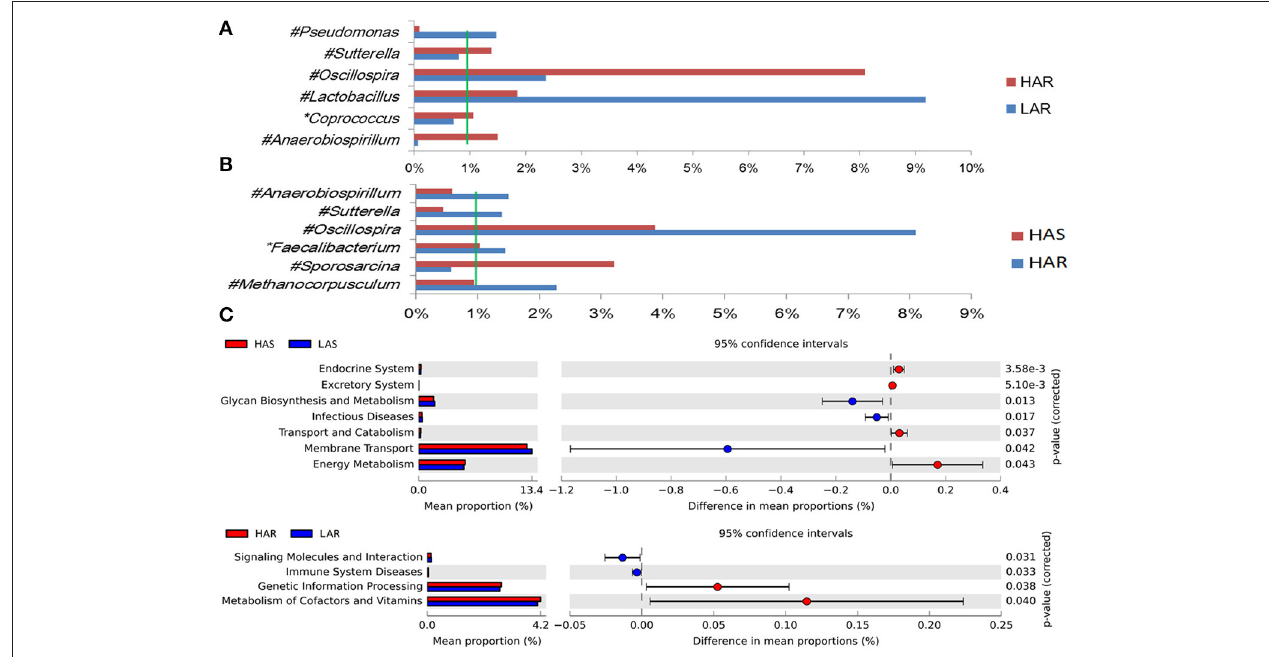
FIGURE 4 | Comparisons of relative abundance at the abundant bacterial genus levels between: (A) HAR vs. LAR, (B) HAR and LAR; * p < 0.05; # p < 0.01. (C) Comparisons of functional pathway between microbes of HAS vs. LAS and HAR vs.